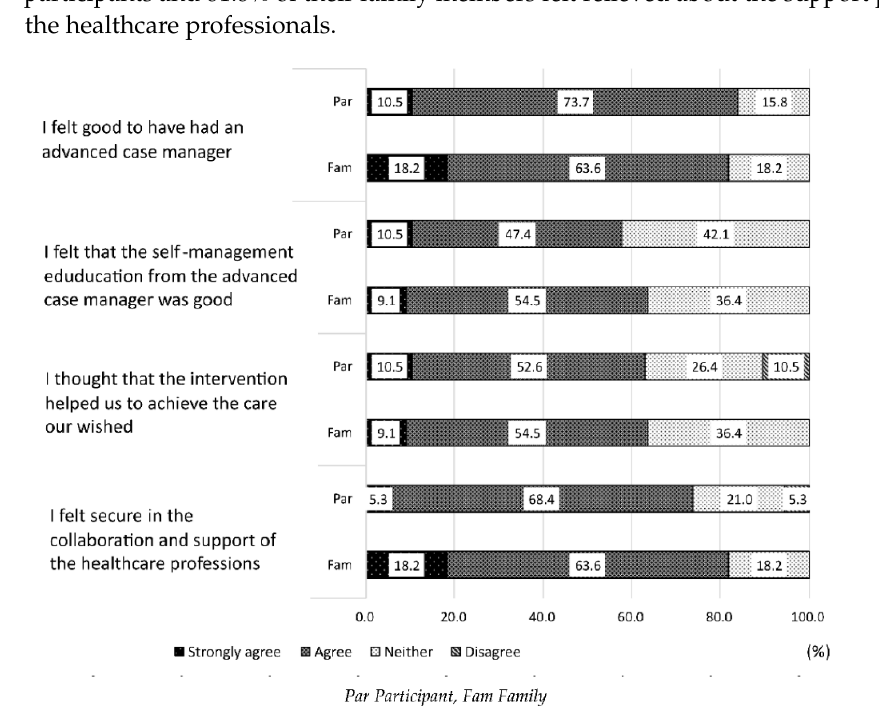
Figure 2. Evaluation of the case management by participants ( n = 19) and family members ( n = 11).